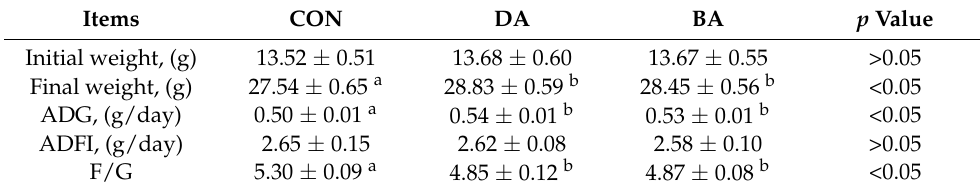
Table 1. Effects of dietary sodium decanoate on growth performance of C57/BL6 mice (Exp. 2) 1,2